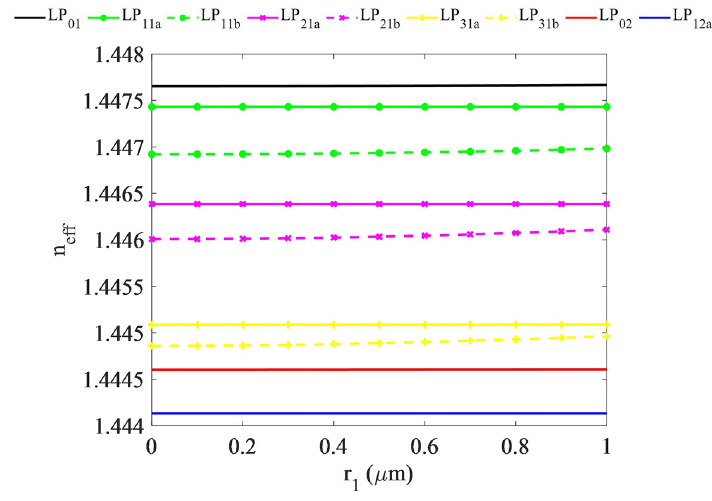
Figure 6. The influence of corner radius on effective refractive index (n eff ) for each mode.